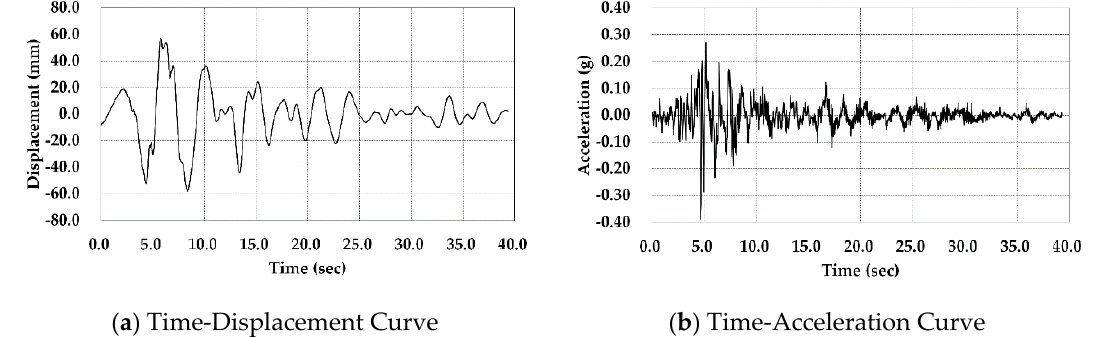
Figure 2. Input time-history curve and measured time-acceleration curve.